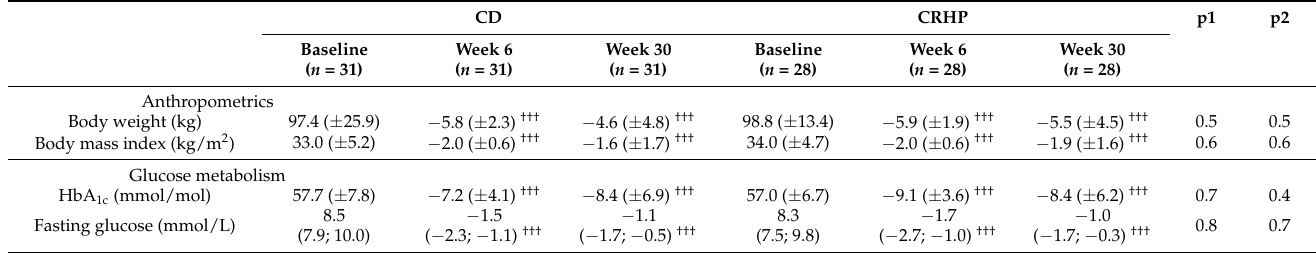
Table 3. Anthropometric and metabolic markers.